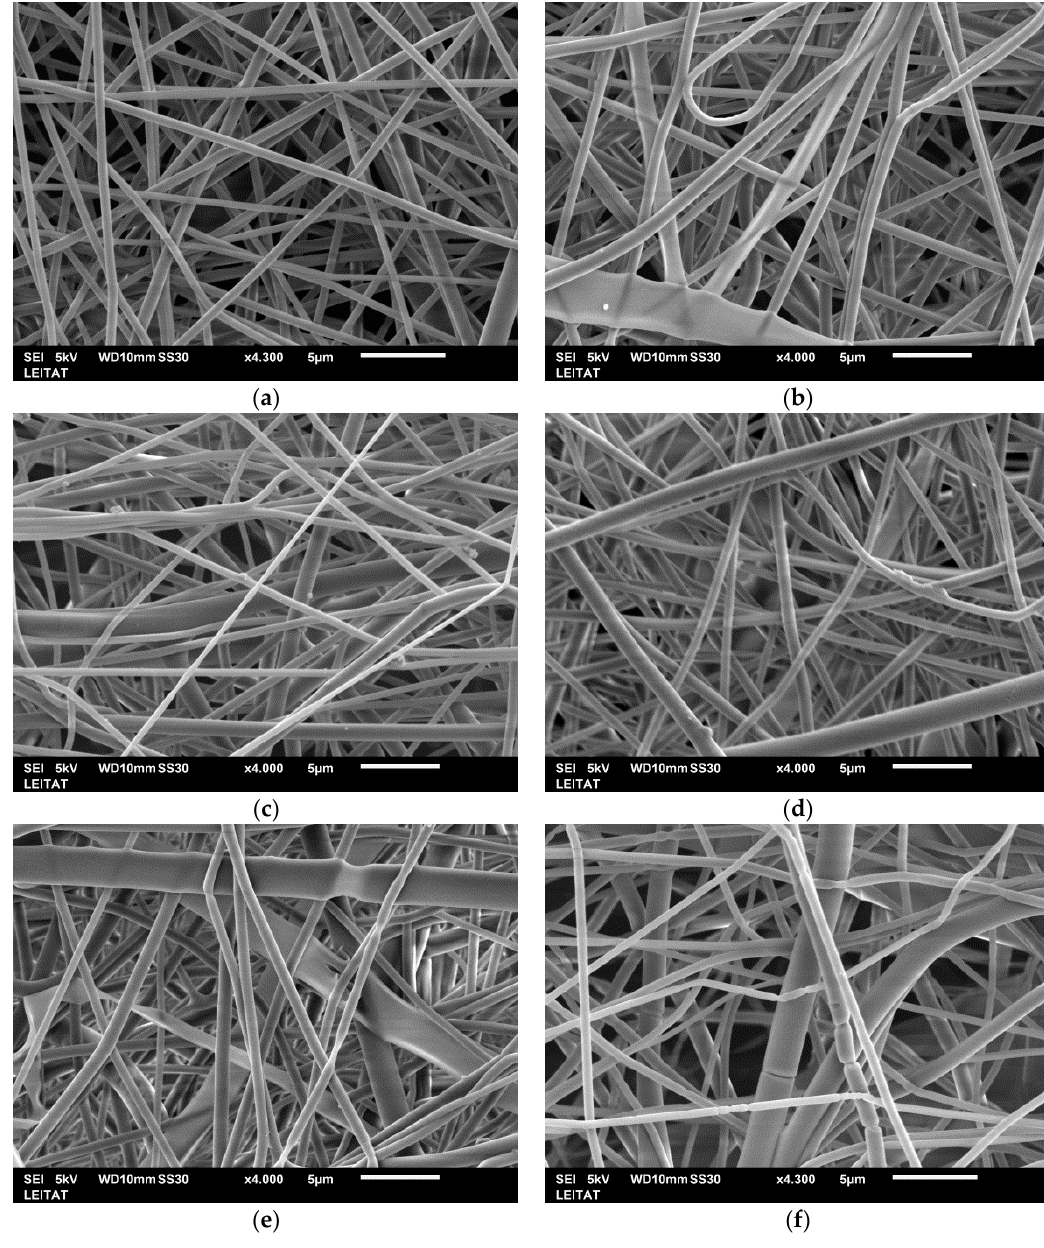
Figure 2. Representative scanning electron microscope (SEM) images of aminated poly(ethylene terephthalate (APET) electrospun fiber mats at different aminolysis conditions over 60 min: ( a ) APET-1, ( b ) APET-3, and ( c ) APET-5; and over 15 min: ( d ) APET-2, ( e ) APET-4, and ( f ) APET-6.